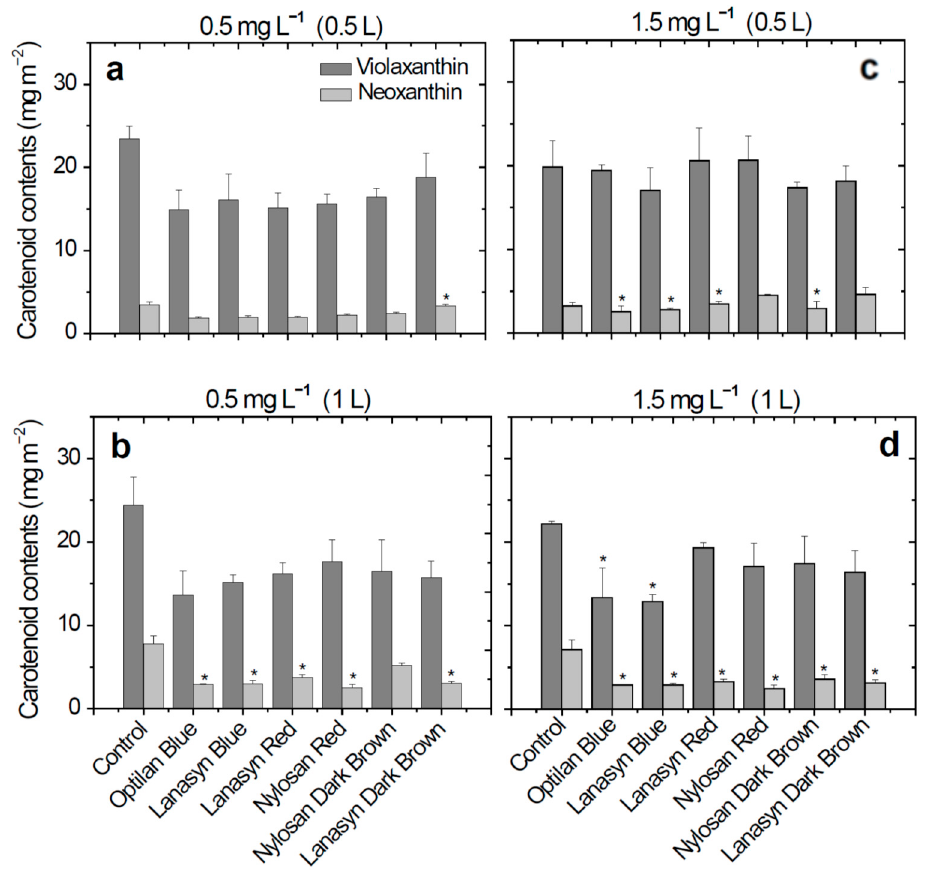
Figure 2. Changes in carotenoid (violaxanthin and neoxanthin) contents (mg m − 2 ) in Triticum aestivum L. cv. “Lovrin” plants in response to treatments with six textile dyes. The plants were watered with a total volume of textile dye solutions of either 0.5 L (one-week-old plants) or 1 L (two-week-old plants) at a concentration of either 0.5 mg L − 1 ( a ) and ( b ) or 1.5 mg L − 1 ( c ) and ( d ). “*” demonstrates statistically significant differences between the given antibiotic treatment and the control ( P < 0.05). The symbols above the columns stand for statistical differences, as in Figure 1.